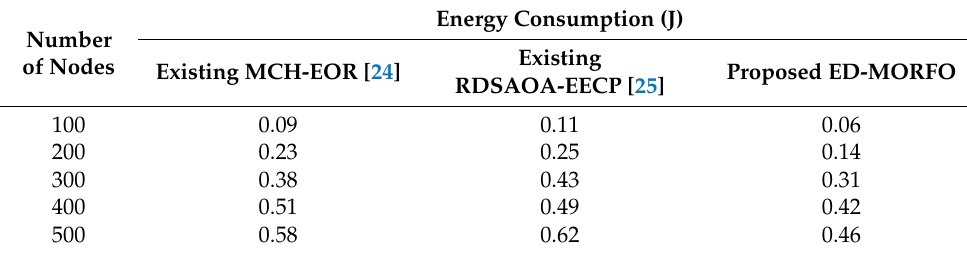
Table 2. Performance of energy consumption.